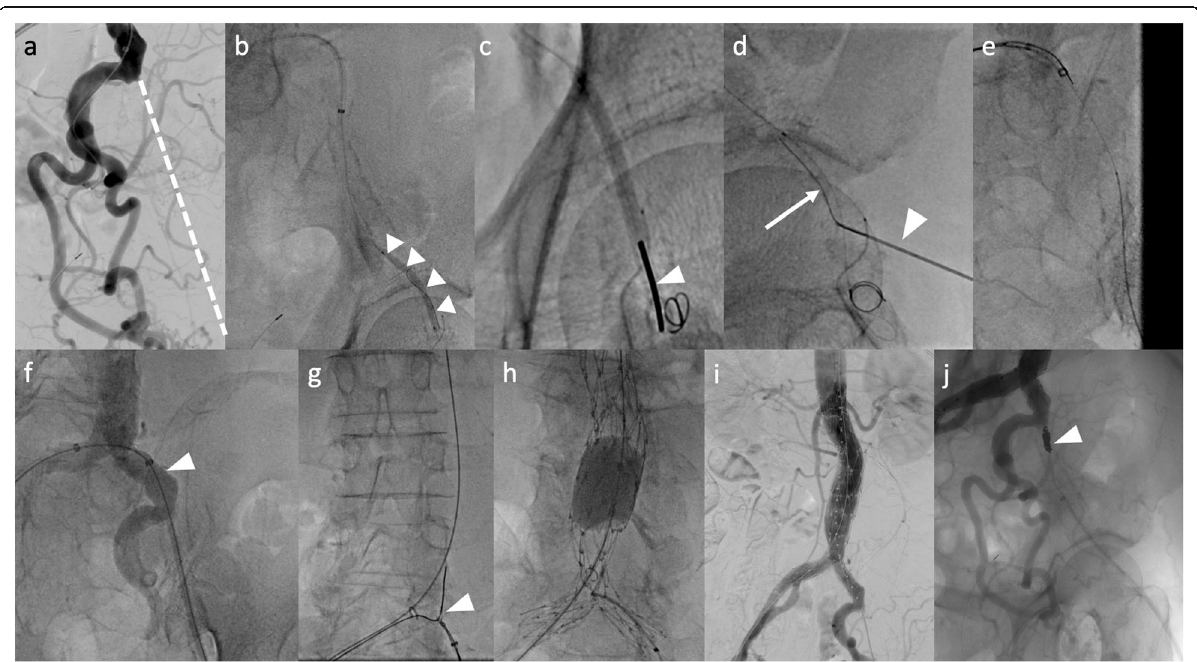
Fig. 2 Procedure detail. a : The angiogram shows the occlusion of left EIA (dotted line), b : An angioplasty balloon was advanced to the occluded CFA and expanded (arrow heads), c : Percutaneous puncture of expanded balloon at the occluded CFA (arrow head), d : A guidewire (arrow) was inserted into the punctured balloon (arrow head), e : A through and through wire was established, f : A 8F sheath was advanced to the left CIA over the through and through wire (arrow head), g : the contralateral wire attached to the endograft was caught by a snare catheter (arrow head) advanced from the left CFA, h : After endograft deployment, a touch-up balloon was expanded inside the endograft, i : Completion angiogram shows a successful exclusion of AAA, j : Coil embolization was performed to occlude the tract where the 8F sheath was advanced (arrow head). AAA: abdominal aortic aneurysm, CFA: common femoral artery, CIA: common iliac artery, EIA external iliac artery